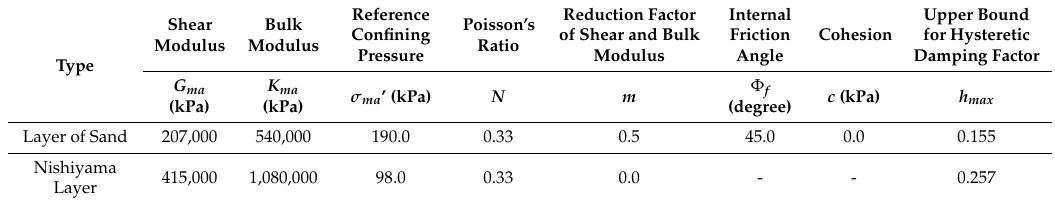
Table 3. Liquefaction characteristics parameters of the soil used for the simulation. Parameter designations are illustrated in